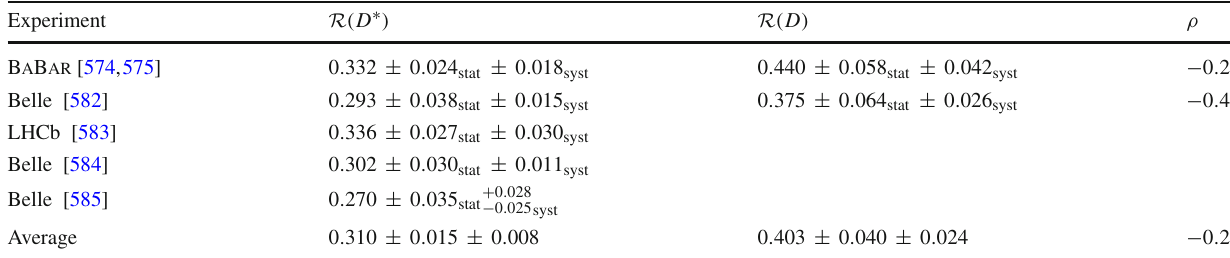
Table 92 Measurements of R ( D ∗ ) and R ( D ) , their correlations and the combined average Experiment